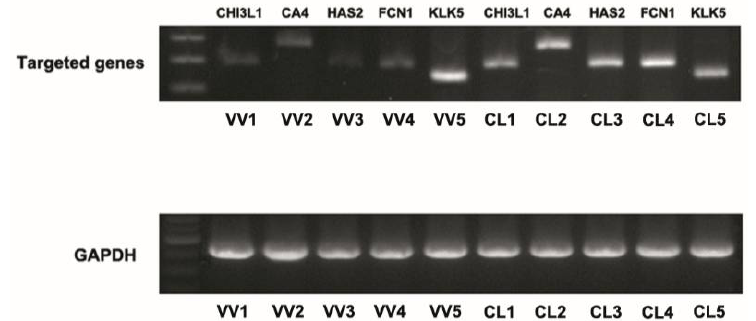
Figure 2. Validation of the differentially expressed genes identified by next-generation RNA sequence technology (RNA seq) using reverse transcription polymerase chain reaction (RT-PCR) in venous samples of control patients (CL) and those of patients with varicose vein (VV). N = 5 for each group.